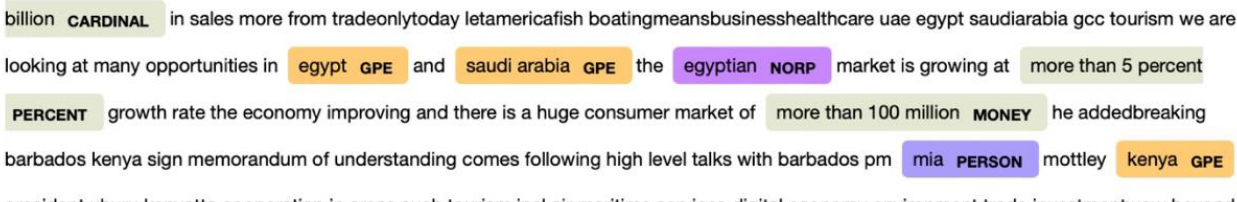
Figure 15. Name Entity Representation for Cluster 1.